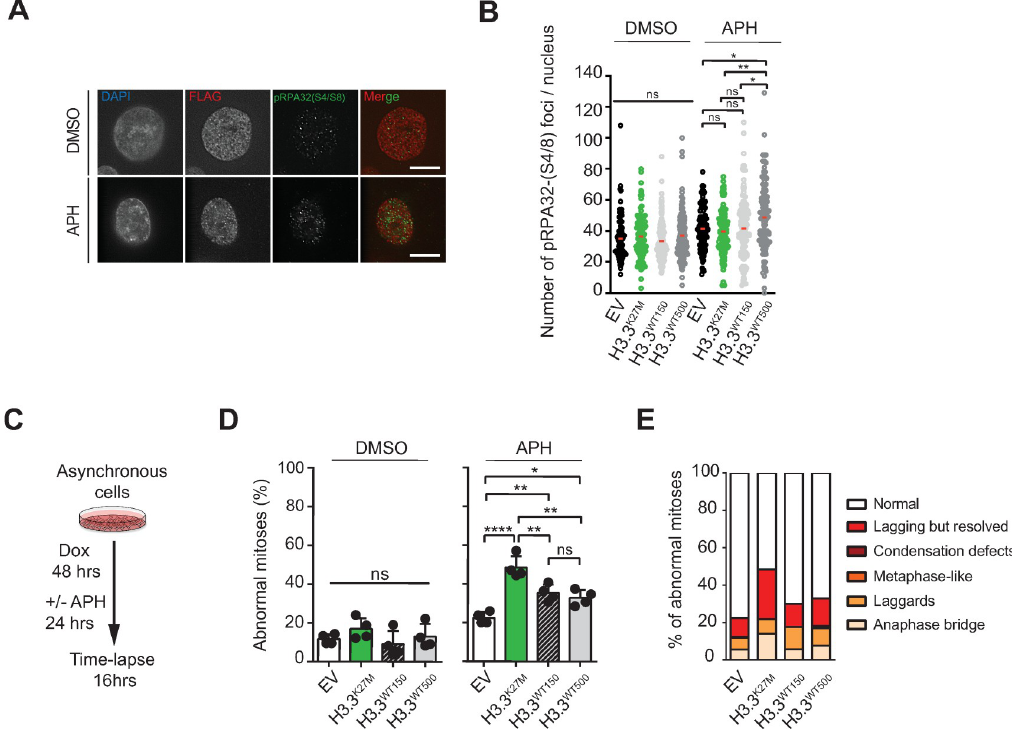
Fig 3. H3.3 K27M RPE1 cells are sensitive to replication stress. (A) Representative images of multiple pRPA32(S4/S8) nuclear foci in untreated and Aphidicolin (APH) treated cells. Scale bars represent 10 μ m. (B) Quantification of the initial replication stress response by pRPA32(S4/S8) staining in DMSO or Aphidicolin (APH) treated cells. Each circle represents a single nucleus, means are represented by a red square (n = 1 experiment with > 95 nuclei per condition), � P = 0.0105 and 0.0126, �� P = 0.0011 (one-way ANOVA, Tukey correction for multiple comparisons). (C) Experimental outline for measuring chromosomal instability by time lapse microscopy under replication stress conditions (low dose (0.2 μ M) Aphidicolin (APH) treatment for 24 hrs on 48 hrs Doxycycline-treated cells). (D) Time lapse imaging of mitotic features following 24 hrs Aphidicolin treatment. Mitotic features were scored as normal, or abnormal. Data represent mean percentages of abnormal mitoses ± SD (n = 4 experiments), with a minimum of 20 mitoses per condition), � P = 0.0258, �� P = 0.0066, 0.0056 and 0.0015, ���� P < 0.0001 (one- way ANOVA, Tukey correction for multiple comparisons). (E) Chart representing type and distribution of mitotic abnormalities after Aphidicolin (APH) treatment. For examples of scored categories, see Fig